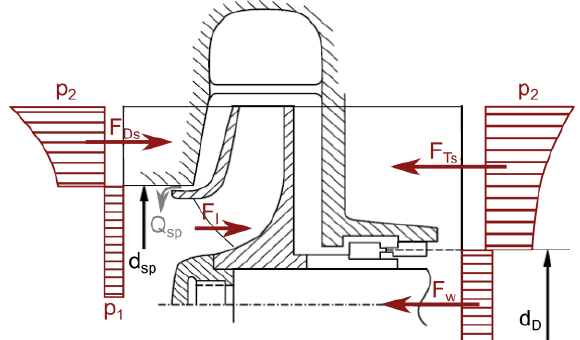
Figure 19. Partial forces acting on impeller in axial direction. Reproduced from [8], Springer: